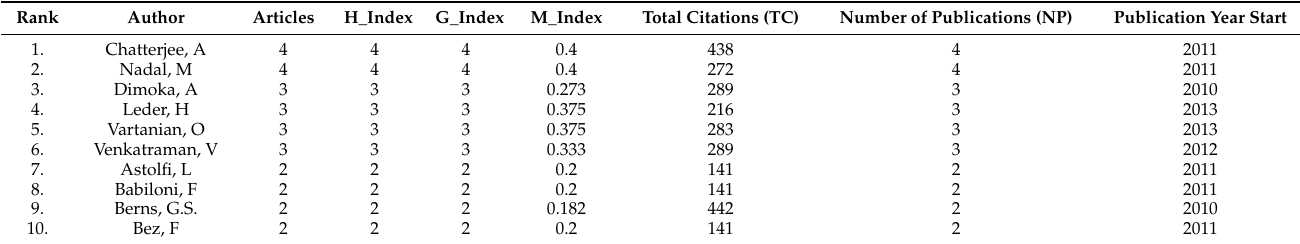
Table 8. Top 10 Most Relevant Authors and Author Local Impact.